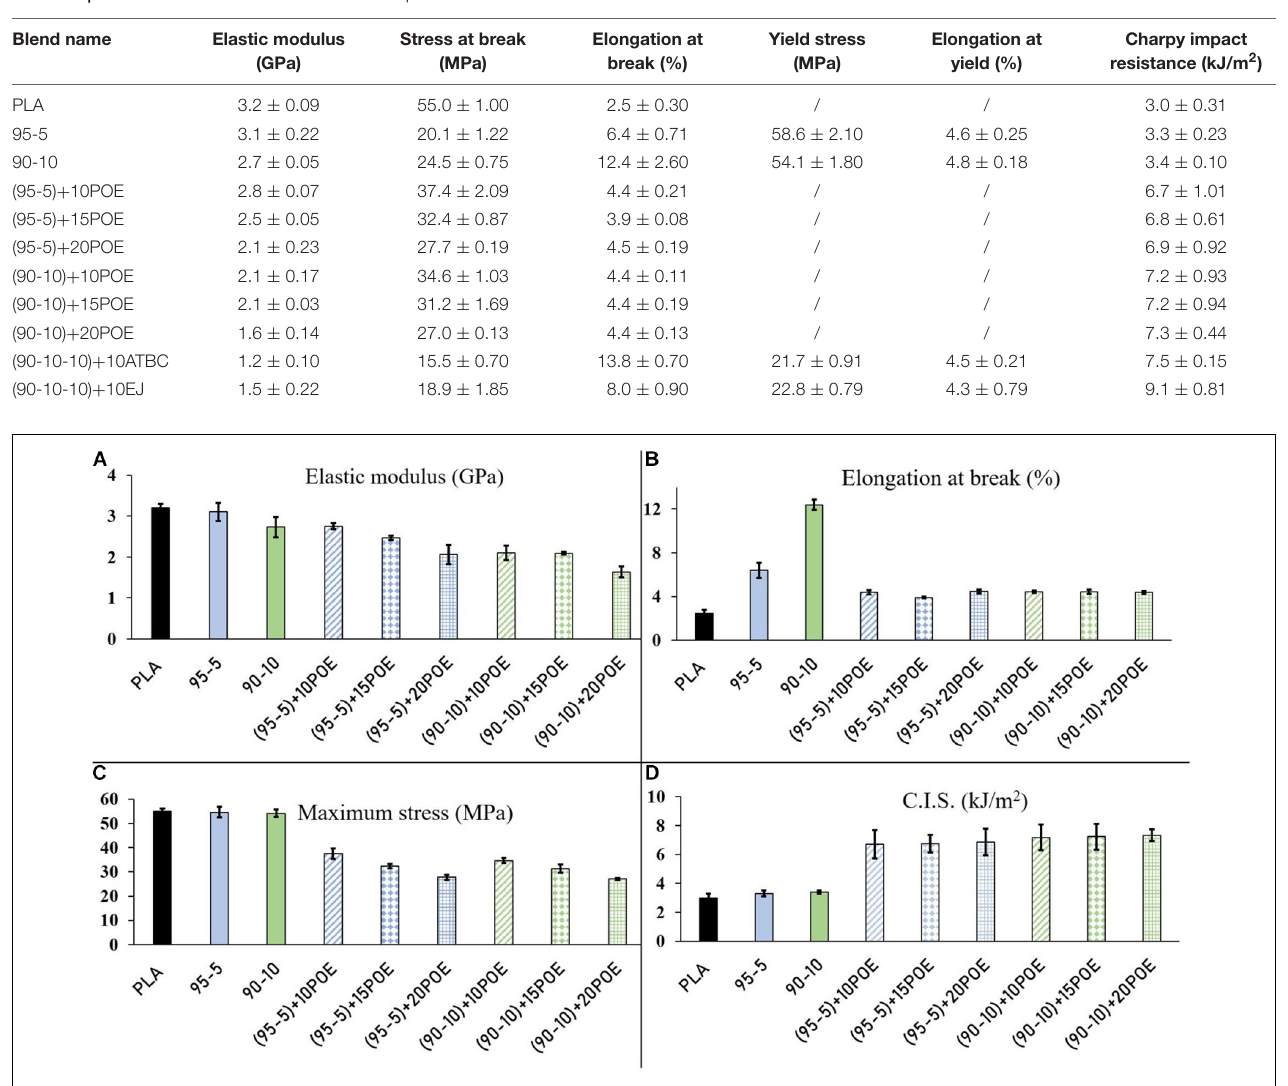
FIGURE 1 | Mechanical properties for PLA, binary blends and ternary blends: (A) Elastic Modulus; (B) Stress at break; (C) Elongation at break (%); (D) Charpy Impact